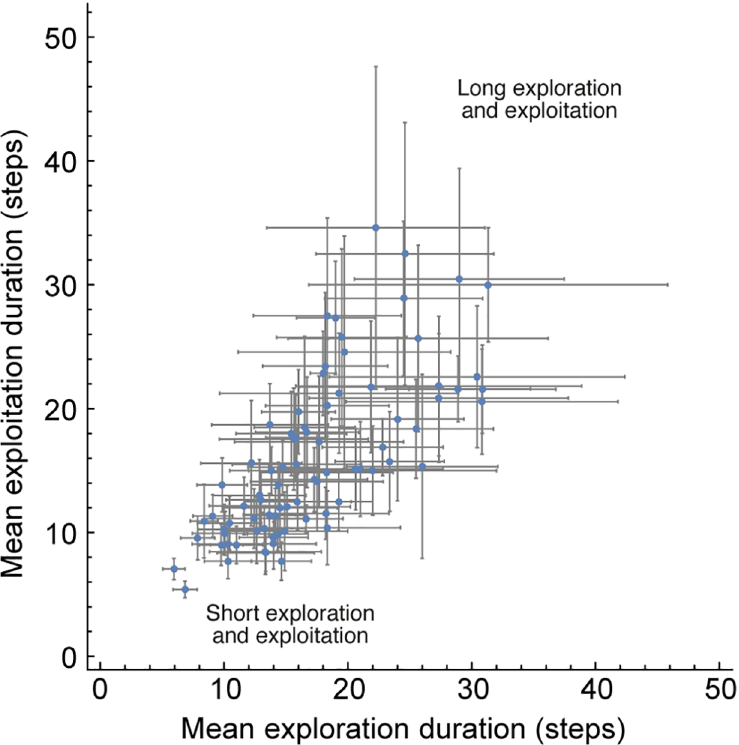
Fig 6. Playersshow correlated mean exploration and exploitation phase durations. Mean and error bars of one std are shown for each player. Spearmancorrelation, r = 0.78, 95% CI = [0.68,0.86], p < 0.001.